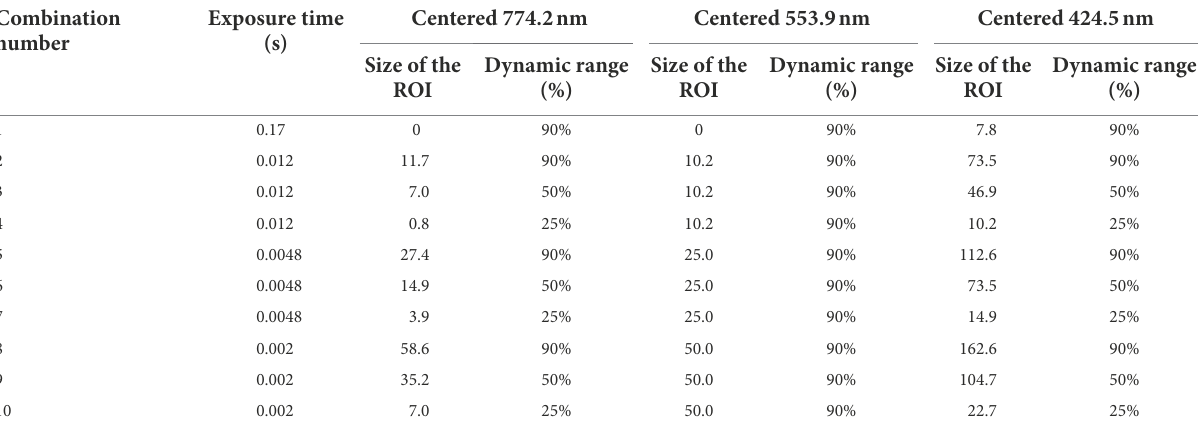
TABLE 1 Combinations of wavelength resolutions and exposure times for QDA and SVM-RBF